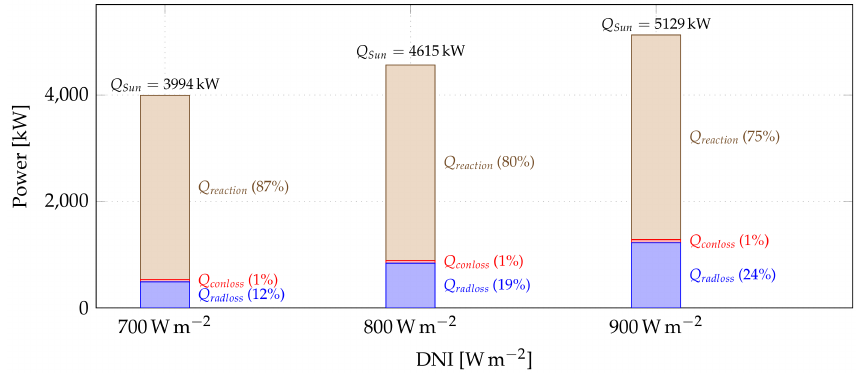
Figure 3. Power balance corresponding to the steady state of the DNI steps in Figure 2.